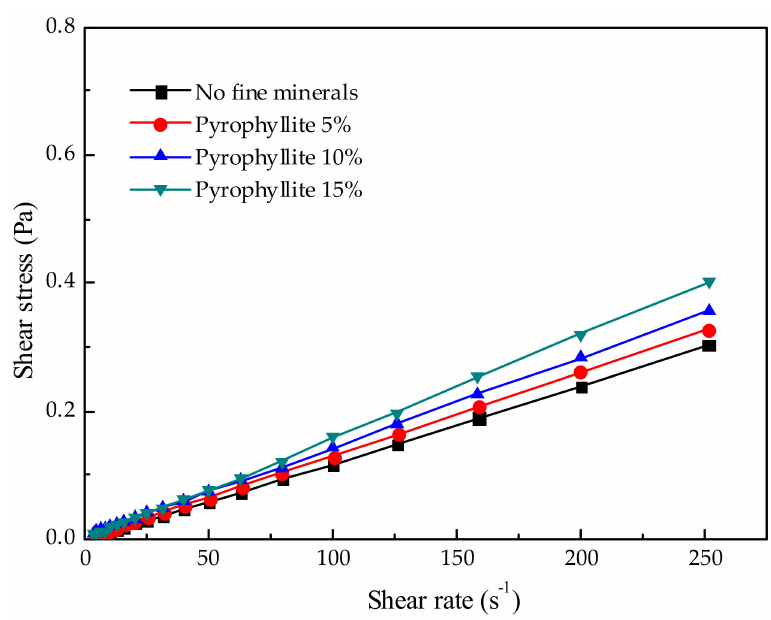
Figure 7. E ff ect of di ff erent pyrophyllite additions on pulp